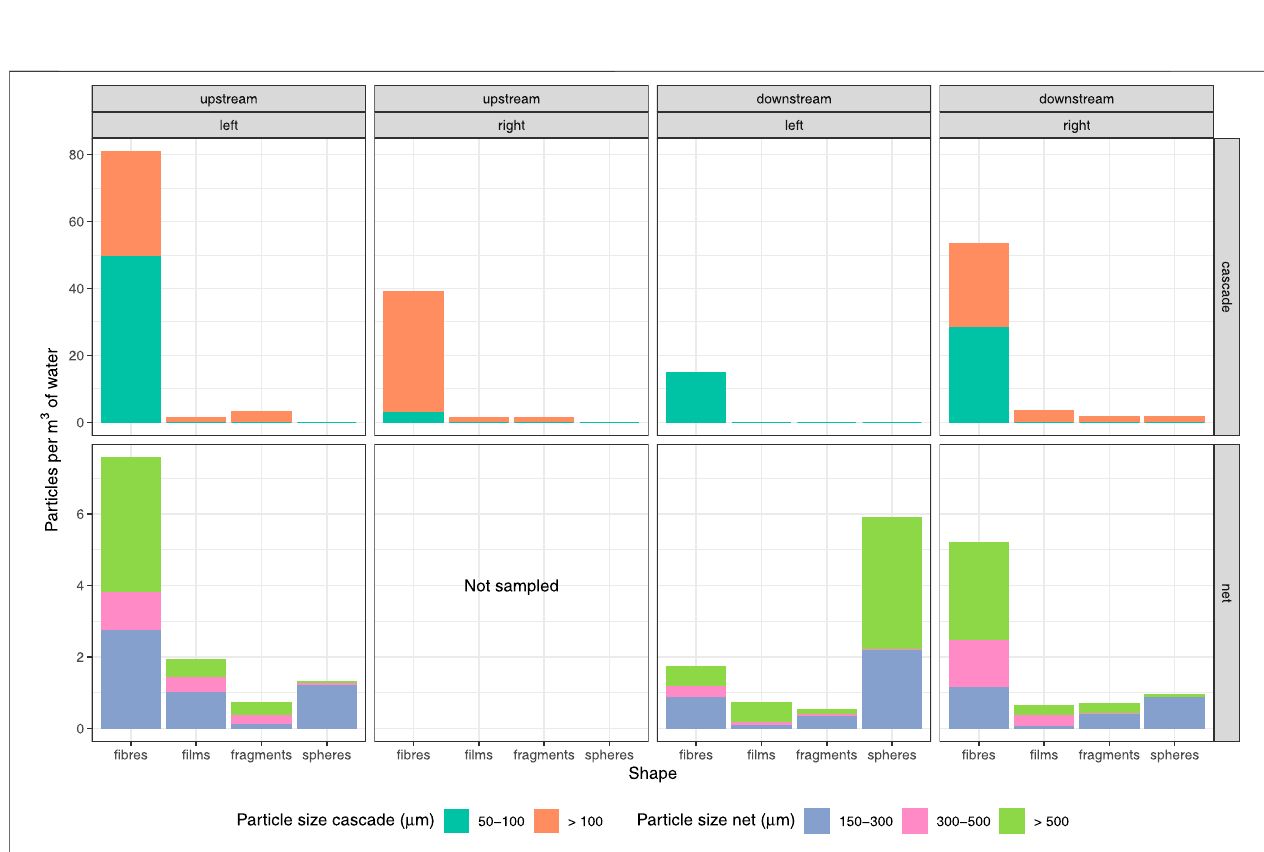
FIGURE 3 | Number of microplastics in water samples by shape. Note different scales on the y axes for cascade and net samples.